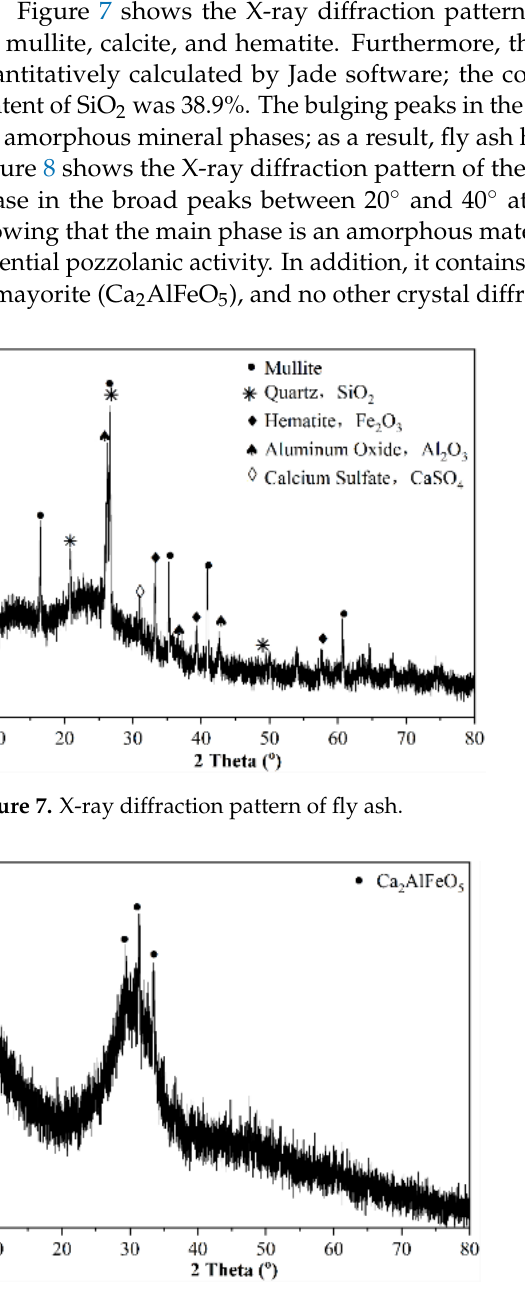
Figure 8. X-ray diffraction pattern of slag powder.